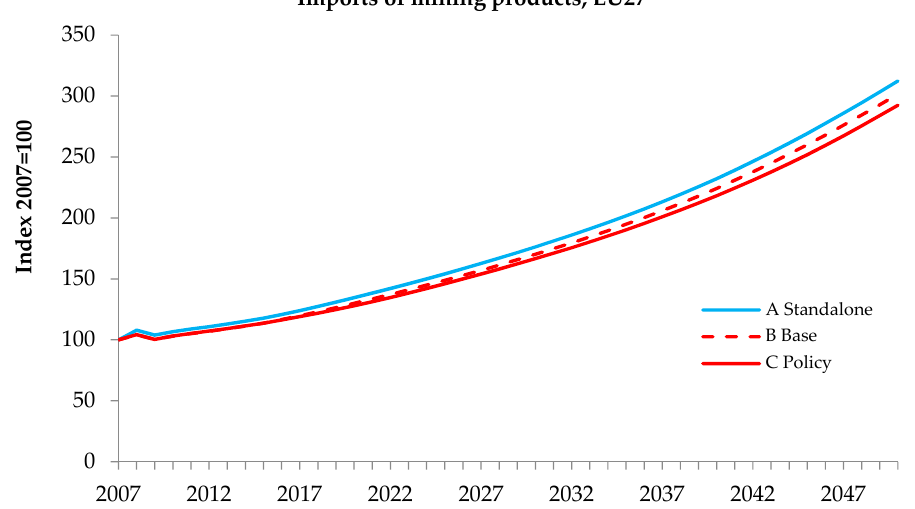
Figure 10. Import of mining products, using A, B, and C settings, in EU27 countries.